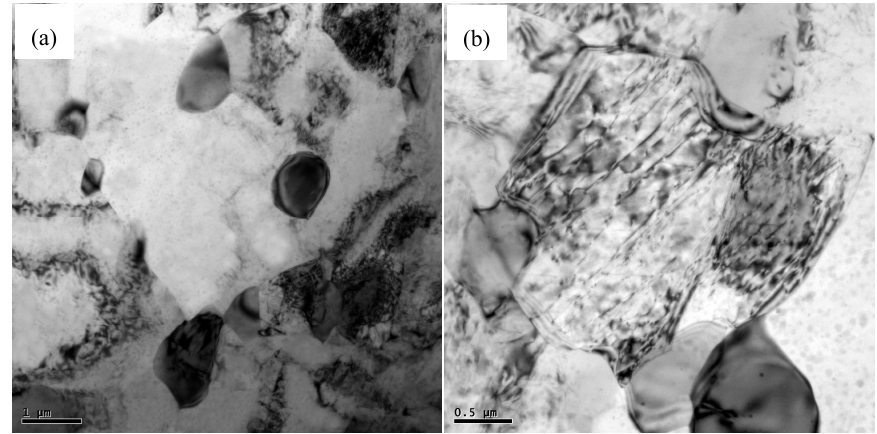
Figure 4. TEM micrographs at high magnification of AZ91 alloy after multi-pass forging for 12 passes (400-6P + 350-3P + 300-3P): ( a ) DRX grains and coarse precipitated phase, ( b ) DRX grains and dislocation.